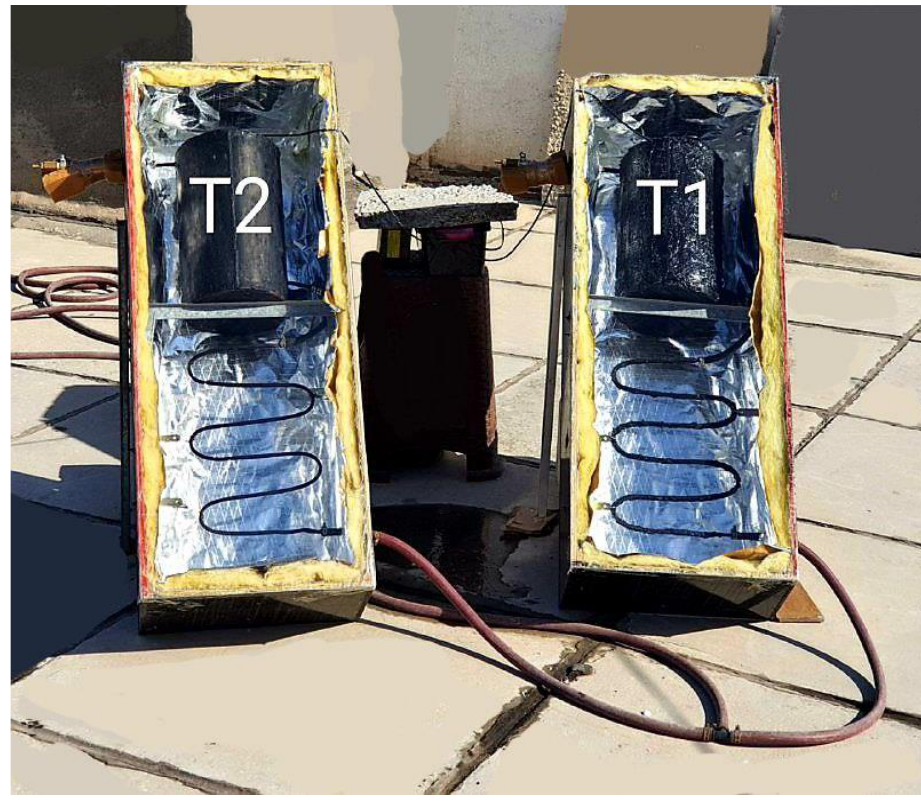
Figure 1: Photograph of the designed solar water heater